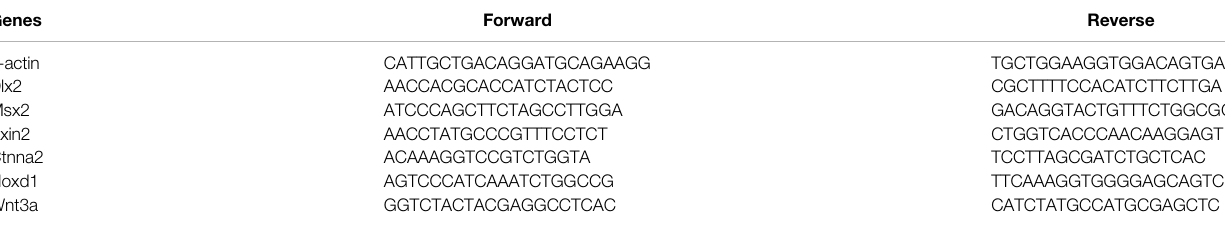
TABLE 1 | List of primer sets used for